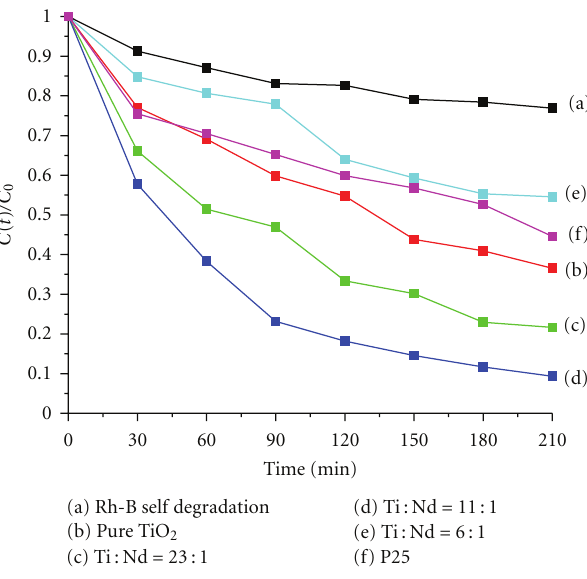
Figure 9: Photocatalytic degradation of Rh-B under visible light (solar simulator: 350 W Xenon lamp with a cuto ff filter) with di ff erent conditions: (a) self degradation, (b) over pure TiO 2 , (c) over Nd-doped TiO 2 with Ti:Nd = 23 :1, (d) over Nd-doped TiO 2 with Ti:Nd = 11 :1, (e) over Nd-doped TiO 2 with Ti:Nd = 6:1, and (f) over